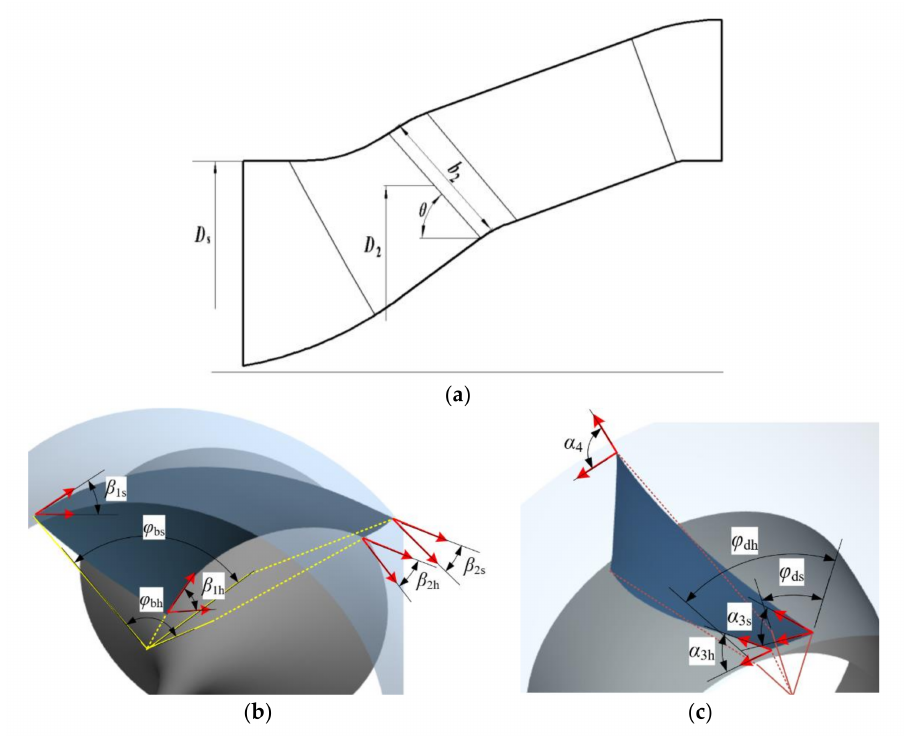
Figure 5. Schematic diagram of geometric parameters. ( a ) Definition of meridional parameters. ( b ) Definition of impeller blade angles. ( c ) Definition of diffuser vane angles. Table 3. Ranges of optimization